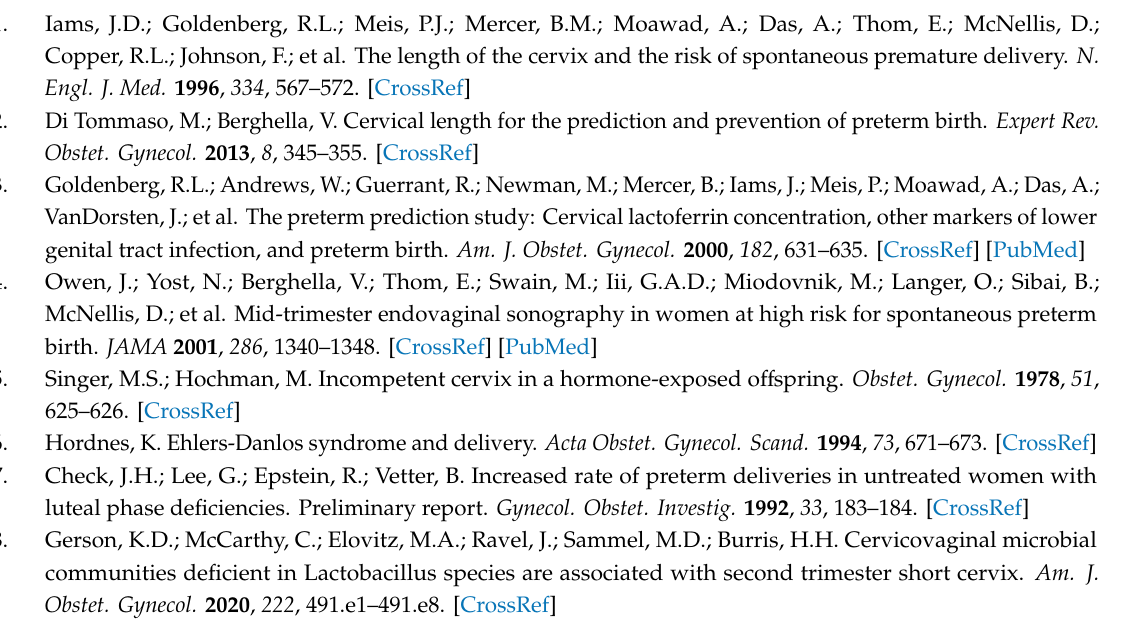
analysis. Table S2: PERMANOVA analysis on PCoA ordination of vaginal microbiota